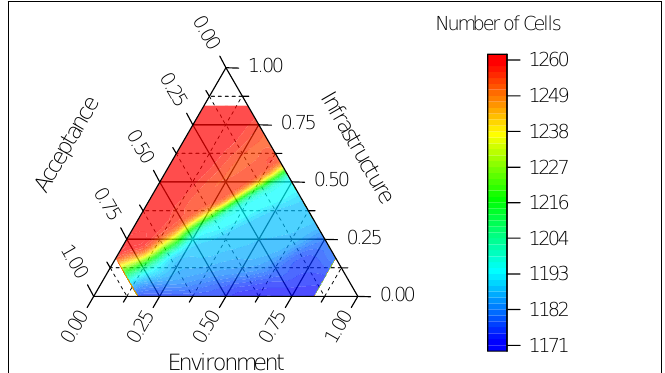
Figure 12. Influence of different weighting factors on the length of the DC SWE/FIN project. Own